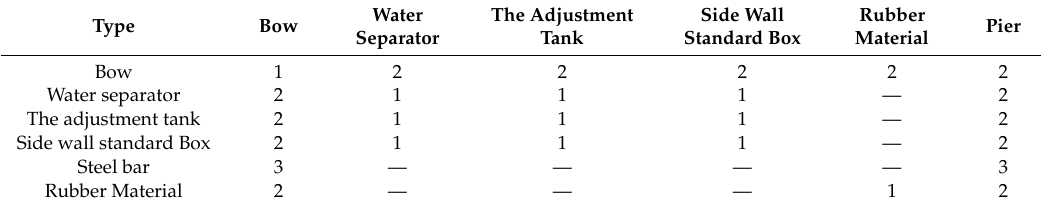
Table 3. Contact Definition of a Cargo Ship Impact Collision avoidance Floating Tank System.